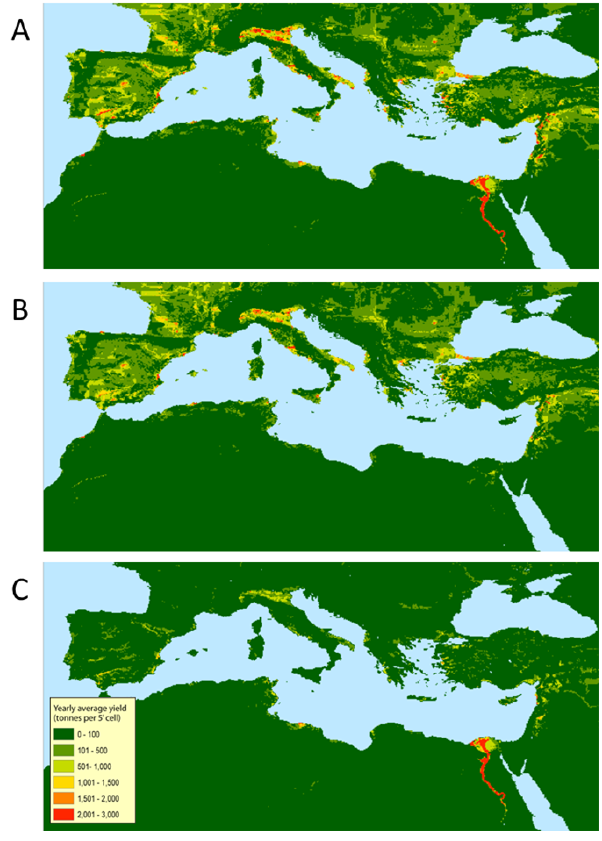
Figure 2. Average cereal yield (tonne per 5 (cid:48) cell). (a) Average cereal yield in tonnes per 5 (cid:48) cell, calculated in PCR-GLOBWB and based on 52 years of climate forcing. The yields from rainfed (b) and ir- rigated (c) agriculture are shown separately. See Fig. S5 for yield in kgha − 1 . Yields are highest in irrigated regions where year-round supply of surface water allows for multi-cropping, which can take advantage of the seasons when temperatures for growth are